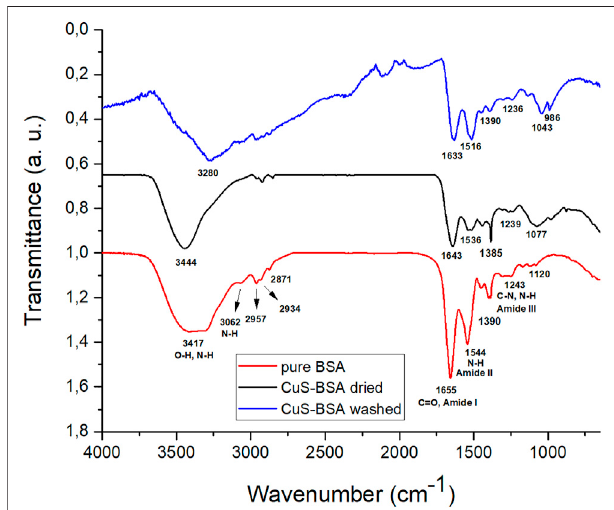
FIGURE 9 | FT-IR spectra: pure BSA (red curve), the dried CuS-BSA sample (black curve) and the washed CuS-BSA sample (blue